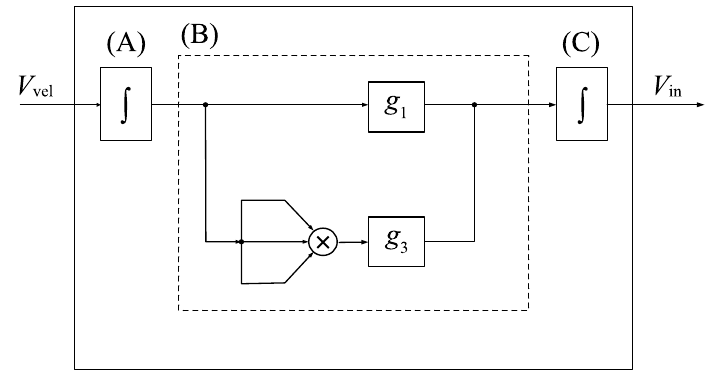
Figure 6. Signal flow in the feedback circuit. The region surrounded by the solid line corresponds to the feedback circuit in Figure 5. ( A , C ) denotes an analog integration circuit. The dashed line block ( B ) represents the field-programmable gate array (FPGA)